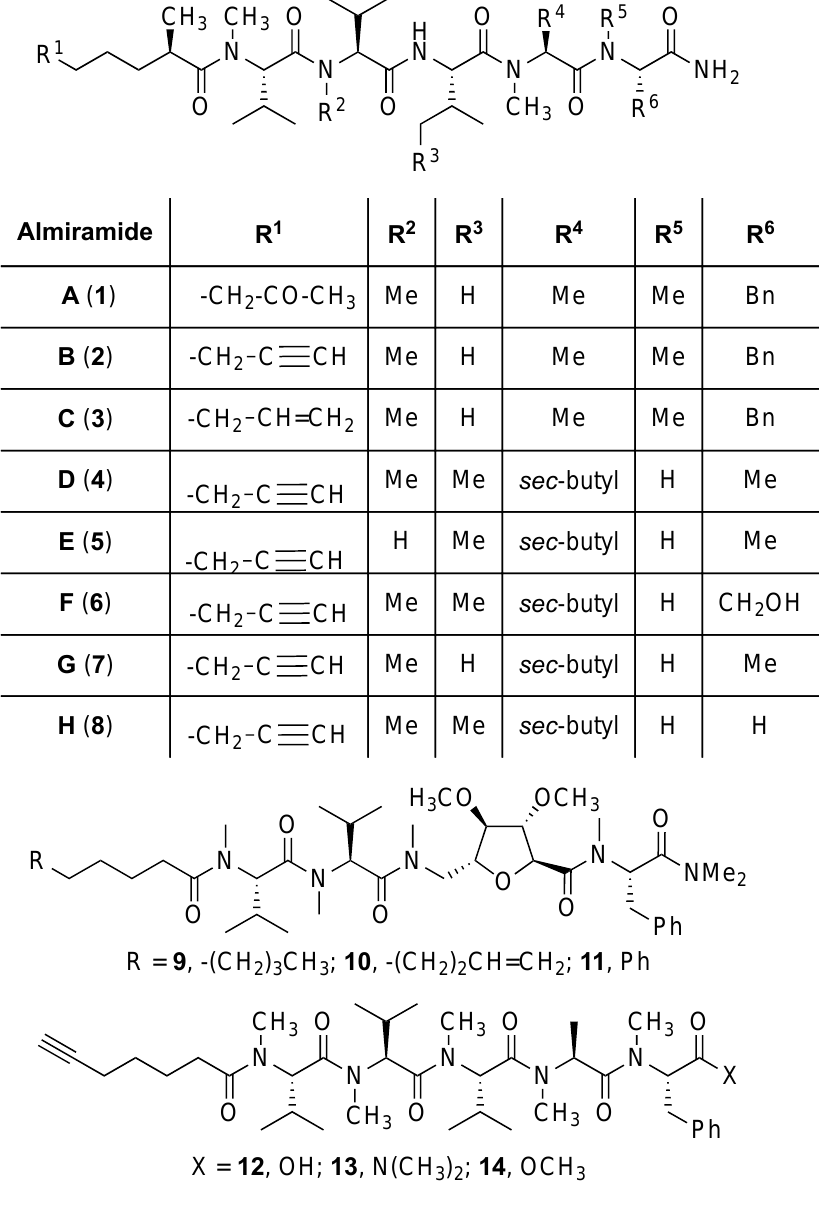
cated the importance of the unsaturated lipophilic terminus. Almiramides B and C ( 2 and 3 , Figure 1) with 2-methyl-7-octynoyl and -7-octenoyl tails were reported to exhibit low N -methylation and conformation for almiramide activity against parasite and host cells. μM activity against Leishmania donovani , but their 2-methyl-7-oxooctanoyl counterpart al- miramide A ( 1 ) was inactive [25]. Employment of a 6-heptynyl lipophilic terminus and N - [e.g., 5 , Val(Me) 1 and Ile(Me) 4 ] to completely permethylated amides (e.g., acid 12 ) methy1 valine 3 in acid 12 and dimethyl amide 13 gave peptides with μM IC 50 values against L. donovani , and improved therapeutic indices with relatively lower cytotoxicity (CC 50 ) against mammalian Vero kidney cells: selectivity index (CC 50 /EC 50 ) 12 = 13 (50.2) > 2 (21.8) > 3 (17.4) [25]. In this series, the significance of the peptide C -terminal was illus- trated by the methyl ester counterpart (e.g., 14 ) of peptide acid 12 , which exhibited a sig- nificant loss of anti-parasitic activity and a relative gain in Vero cell cytotoxicity [25]. In addition, peptide 2 and novel almiramides D-H ( 4 – 8 ) possessing the common 2-methyl-